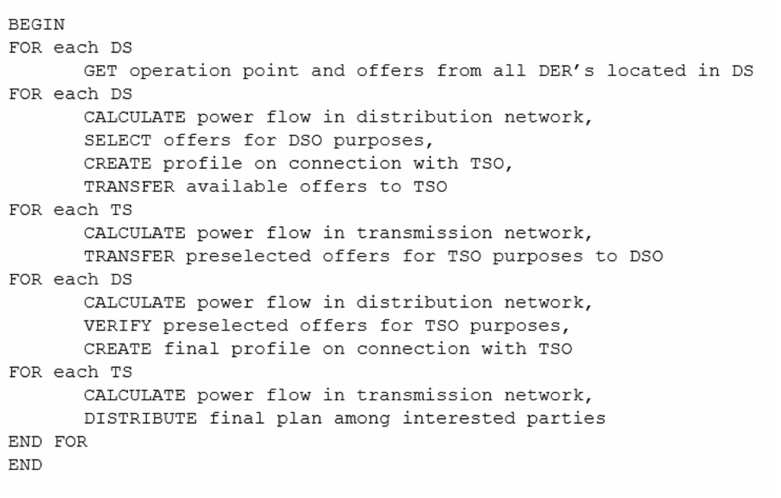
Figure 5. Pseudocode for proposed